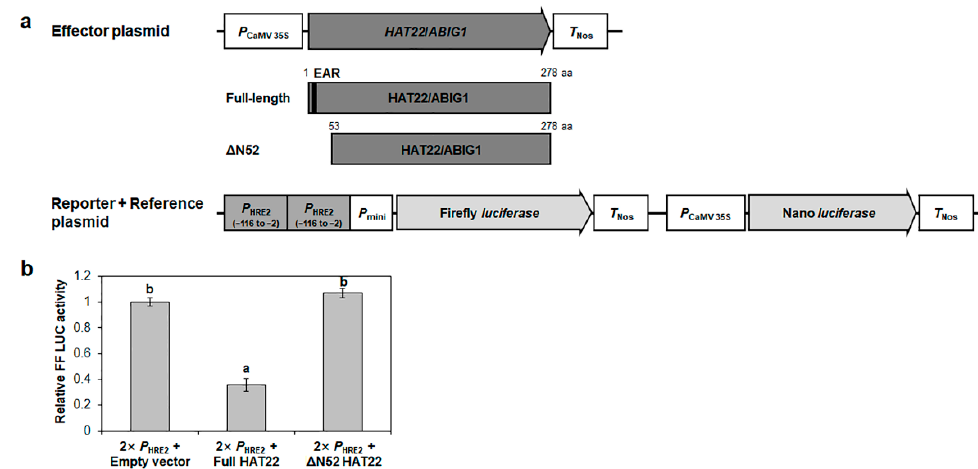
Figure 7. Transrepression assay of HAT22/ABIG1 via HRE2 promoter. ( a ) Schematic maps of effector and reporter+reference plasmids for the transrepression assay. Black bar in HAT22/ABIG1 indicates EAR motif. ( b ) The relative firefly luciferase activity in Arabidopsis protoplasts. The transformation efficiency was normalized using Nano luciferase activity. The normalized firefly luciferase activity of the negative control was set as 1. The empty effector plasmid was used for the negative control. Data are shown as means ± S.D. ( n = 5). Different letters display significant differences ( p < 0.05).